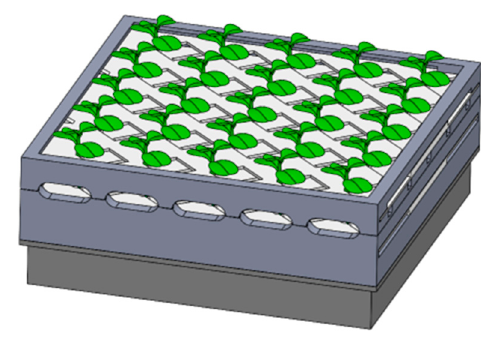
Figure 5. The rootstock and scion plug trays shifted to the left, with the scions fixed.